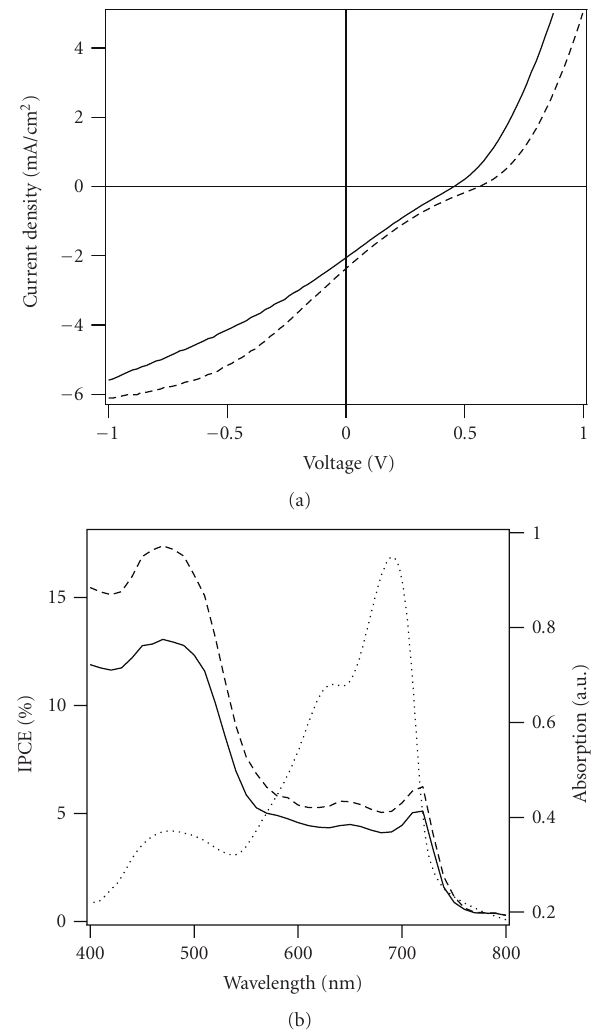
Figure 5: Current-voltage characteristics (a) and IPCE curves (b) of pristine (full line) and doped (dashed line) solar cells based on SQ02. The absorbance of the cell is also indicated (dotted